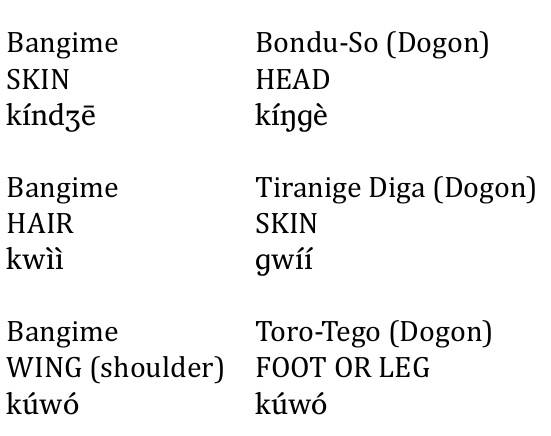
Table 7: Similar word forms for body parts with shifted